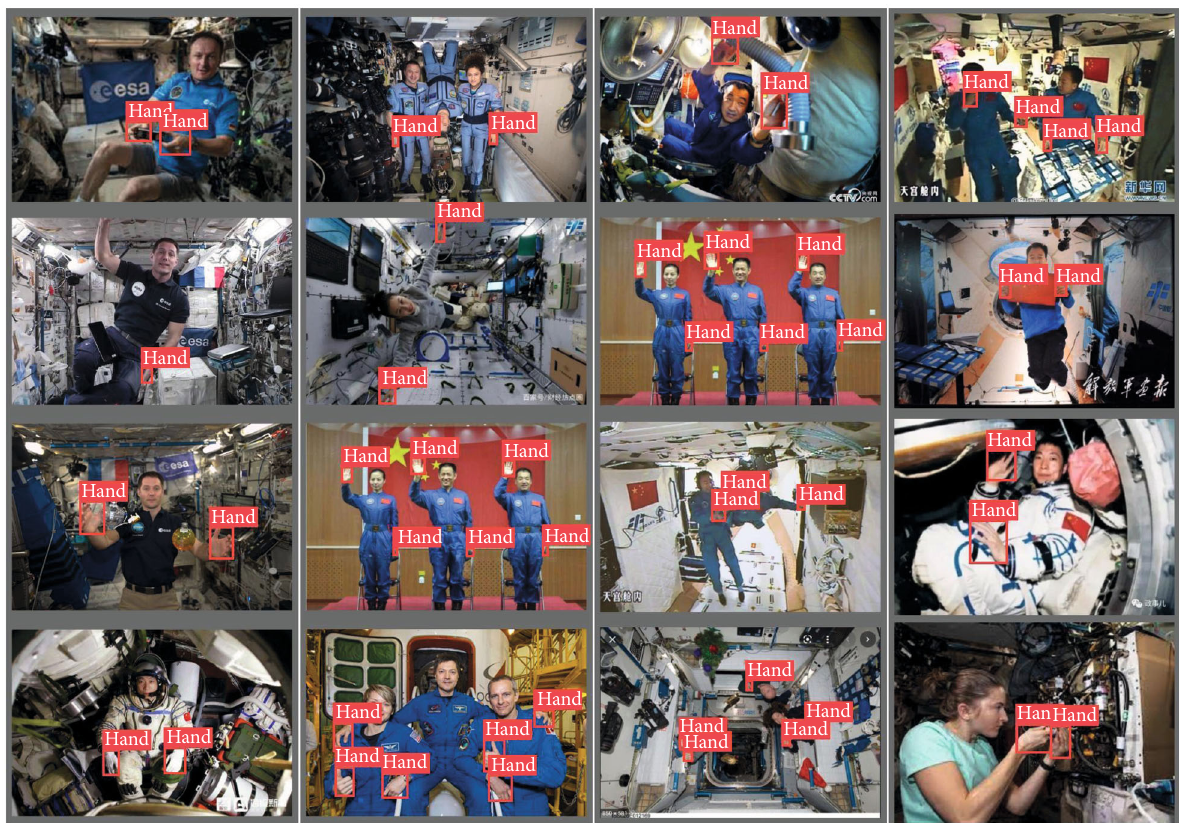
Figure 6: Some hand detection results on the AHD dataset.